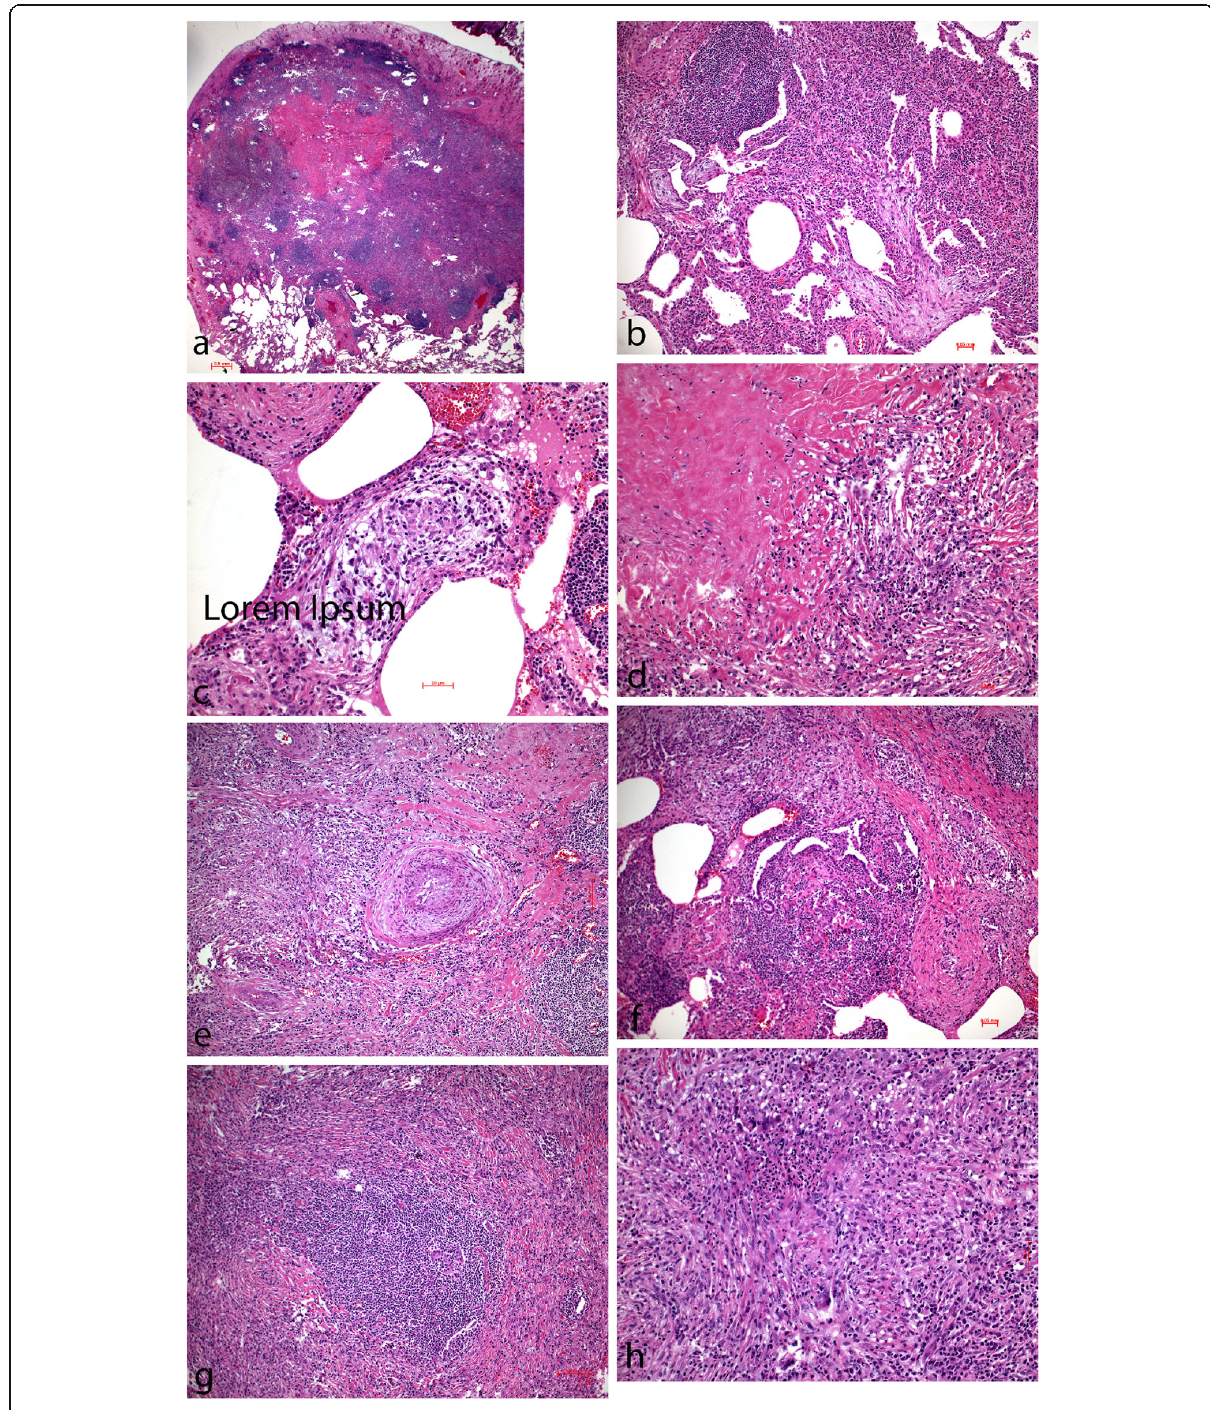
Fig. 16 Chronic rhA, a ) overview, b ) myofibroblastic foci with dense lymphocytic infiltration and lymph follicle, and cystic remodeling; c ) lose epitheloid cell granuloma, d ) amyloid deposit, e ) dense lymphocytic infiltration and vasculopathy with severe narrowing of a pulmonary artery, f ) cystic remodeling, lose granulomas with giant cells, lymphocytic accumulation, g ) BALT hyperplasia, h ) lose granulomas and focal necrobiosis with neutrophils. H&E, bars 500, 100, 50, and 20 μ m,